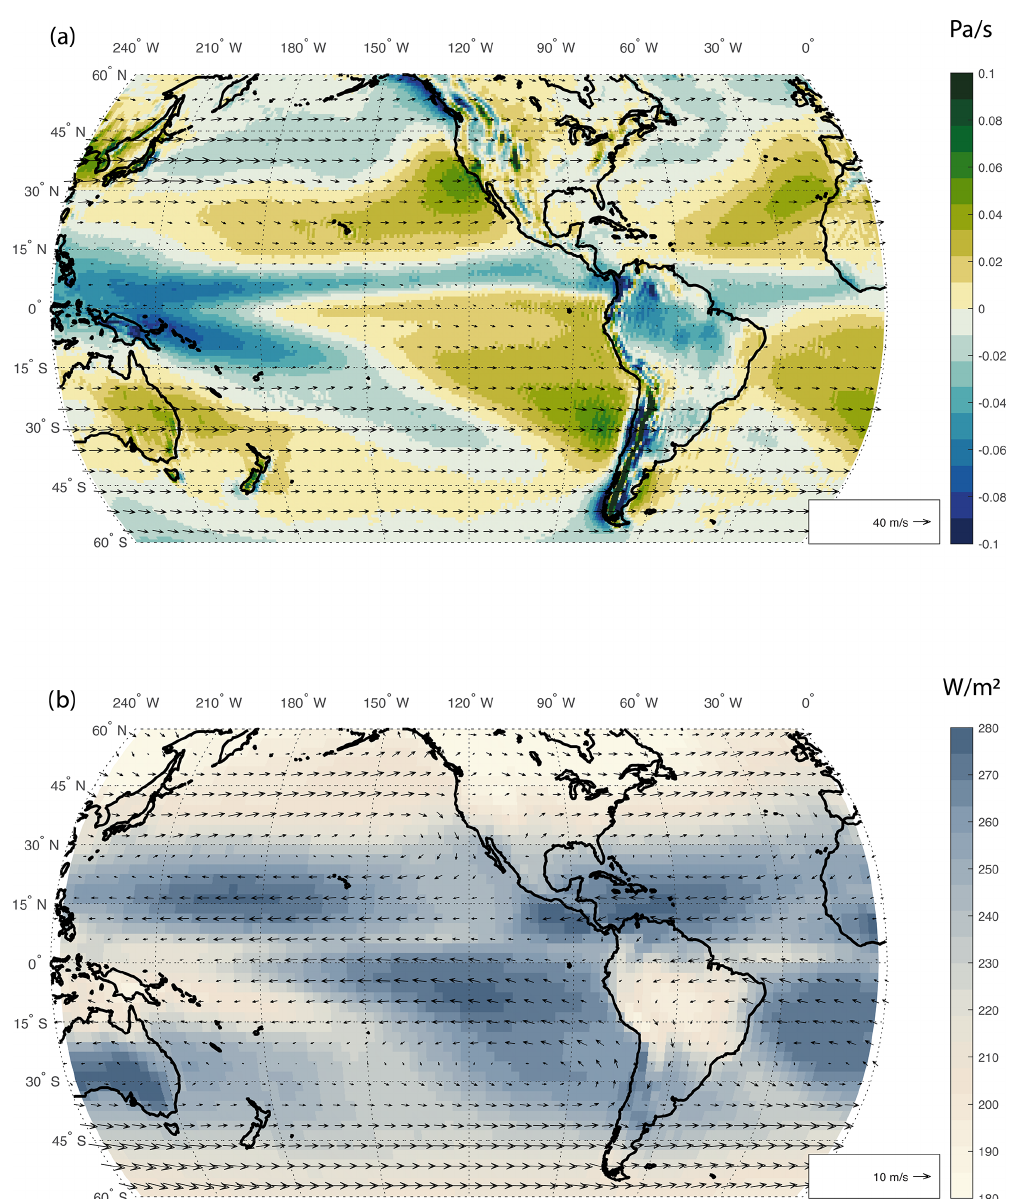
Figure 2. (a) Climatological mean of omega vertical velocity (colors in Pas − 1 ) and 200hPa winds (vectors) from ERA-Interim reanalysis for the period between 1990 and 2009. (b) NOAA-interpolated outgoing longwave radiation from 1981 to 2010 in Wm − 2 (colors) and 850hPa winds (vectors) from ERA-Interim (https://www.ecmwf.int/en/forecasts/datasets/reanalysis-datasets/era-interim, last access: May